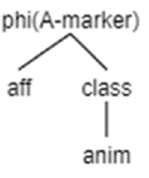
Figure 20. Geometry of the Phi label.